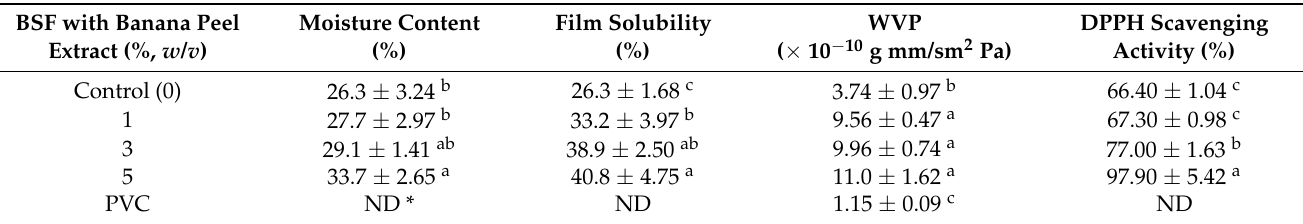
Table 2. Moisture content, film solubility, water vapor permeability, and DPPH scavenging activity of banana starch films incorporated with banana peel extract at different